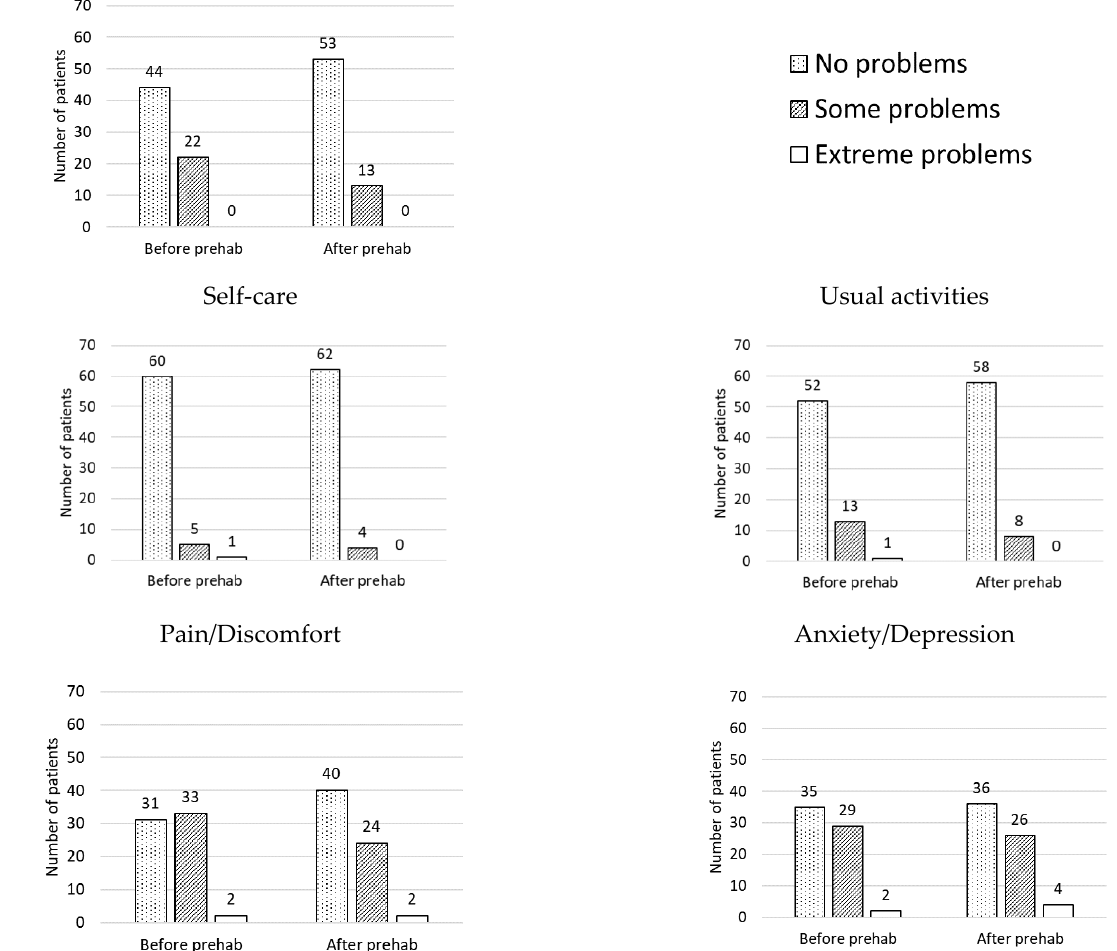
Figure 2. Number of patients per dimension (mobility, self-care, usual activities, pain/discomfort, and anxiety/depression) and level of problems (no problems, some problems, extreme problems), before and after undergoing prehabilitation. A greater number of patients selecting “No problems” in the different dimensions after undergoing prehabilitation suggests the intervention was effective in improving quality of life.